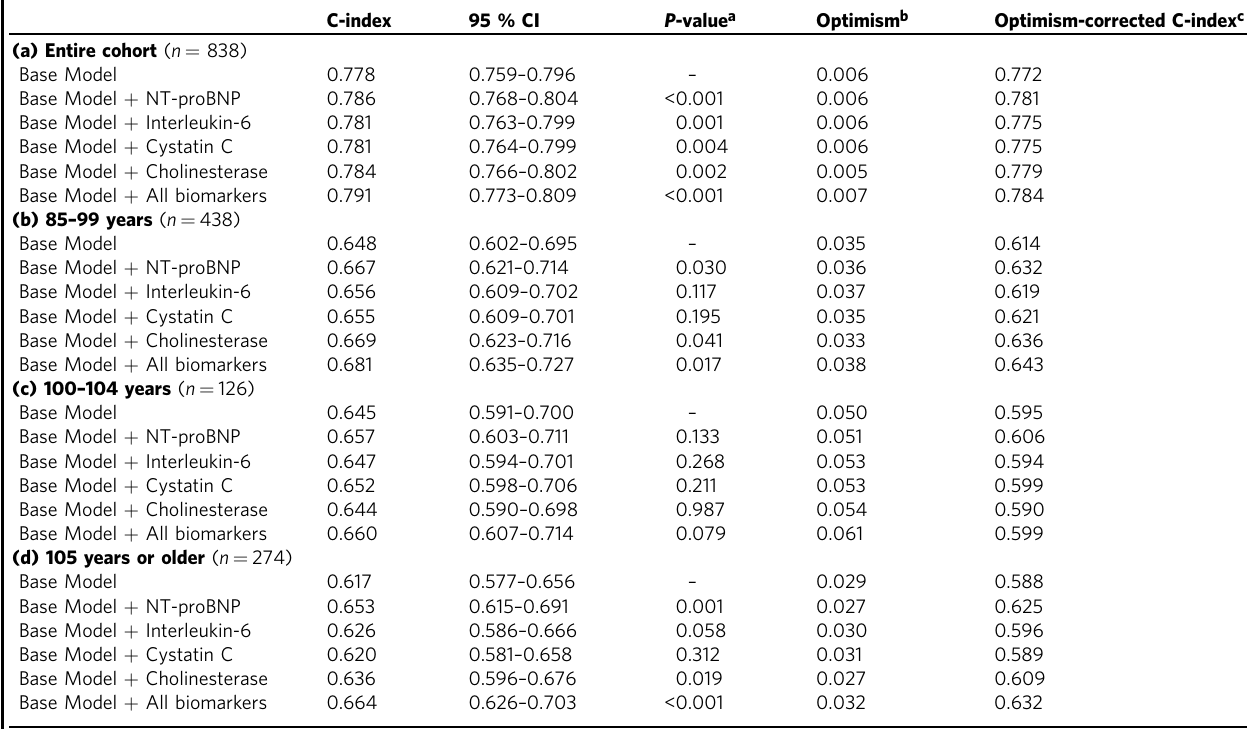
Table 2 The prognostic performance for all-cause mortality in the entire and age-strati fi ed cohort based on Cox proportional hazard